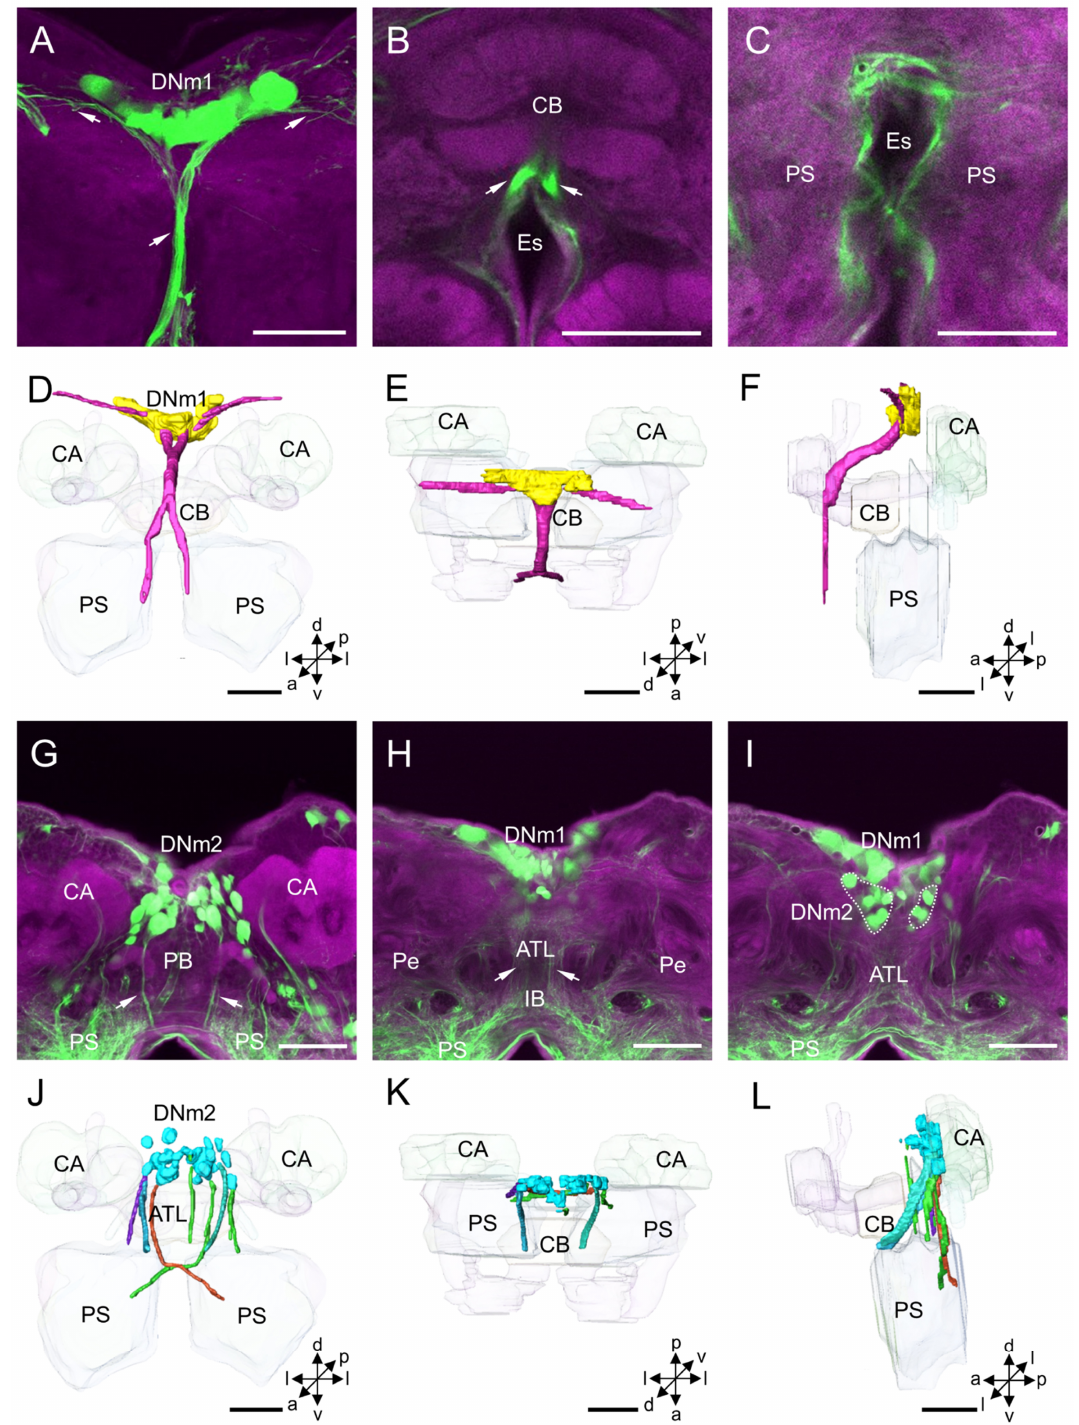
Figure 4. Distribution and projection patterns of DNm neurons in the brain: ( A – C ) projection views of confocal stack images showing DNm1 somata and primary neurites (arrows); ( D – F ) the anterior, dorsal, and lateral views of the three-dimensional reconstruction showing DNm1 somata and primary neurites in the brain; and ( G – I ) projection views of confocal stack images showing DNm2 somata and primary neurites (arrows). ( J – L ) the anterior, dorsal, and lateral views of the three-dimensional reconstruction of DNm2 somata and primary neurites in the brain. ATL, antler; CA, calyx; CB, central body; Es, esophagus; IB, inferior bridge; PS, posterior slope. a, anterior; d, dorsal; l, lateral; p, posterior; v, ventral. Scale bars: 100 µ